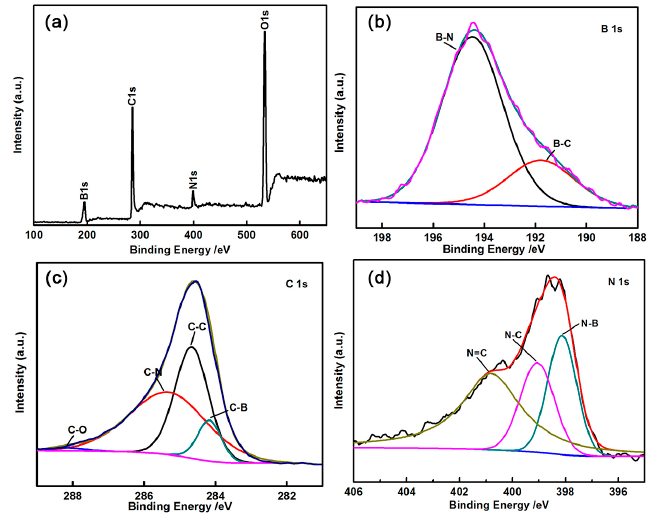
Figure 4. X-ray photoelectron spectroscopy (XPS) scan survey spectra of thin BCN sheets ( a ); B 1s ( b ); C 1s ( c ) and N 1s ( d ).